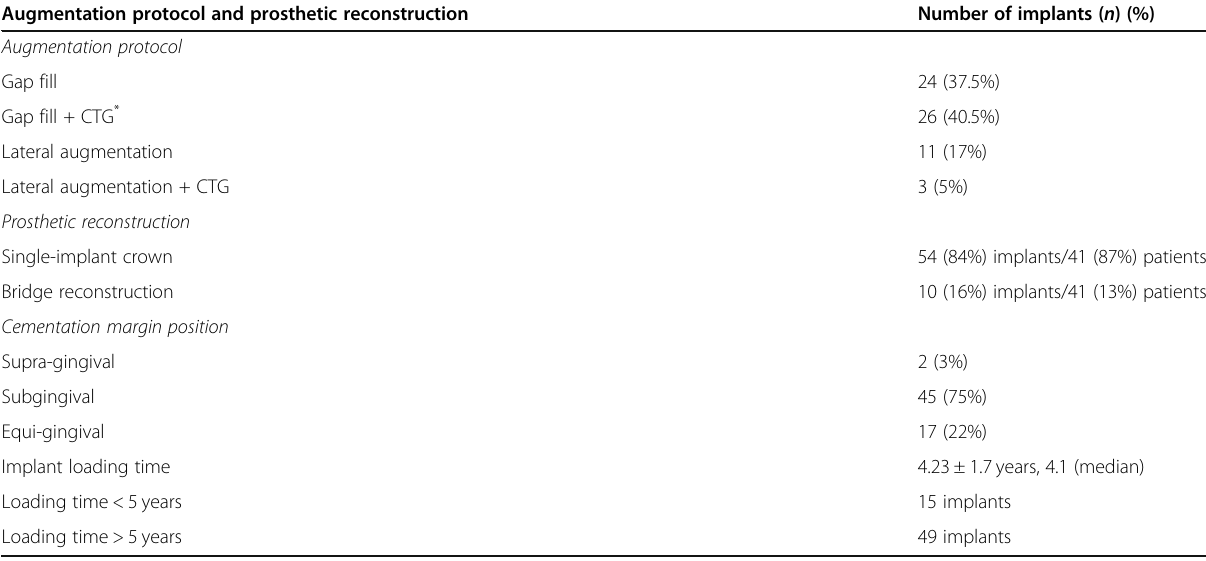
Table 3 Augmentation protocol and prosthetic reconstruction Augmentation protocol and prosthetic